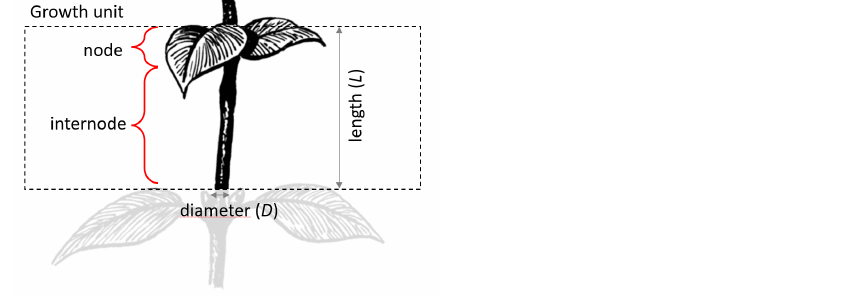
Figure 1. Growth unit (node and internode) elements and simulated dimensions (ODE state